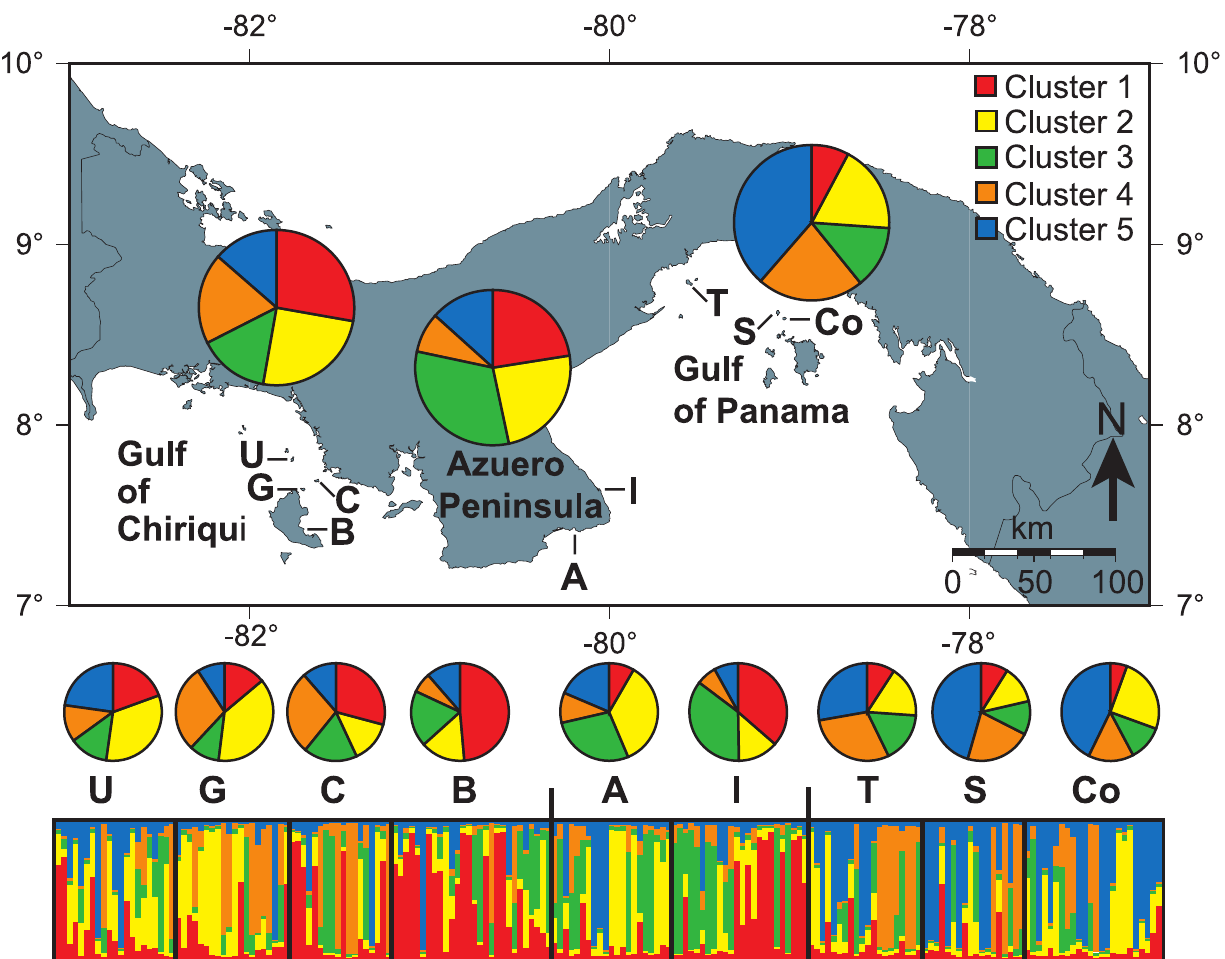
Figure 1. Map of Panama, showing the three main Pacific regions and the sampled locations. The pie charts show the distribution of the five genetic clusters identified by STRUCTURE 2.3 [141] in the three regional and nine reef populations. The bar plot shows each individual sample as a vertical bar with colors indicating the relative proportions of each genetic cluster. Map created on www.aquarius.ifm-geomar.de. U=Uva Island; C=Canal de Afuera Island; G=Granito de Oro Island; B = Bahia de Damas, Coiba Island; A = Achotines Bay; I = Iguana Island; S = Saboga Island; Co = Contadora Island; T = Taboga Island.